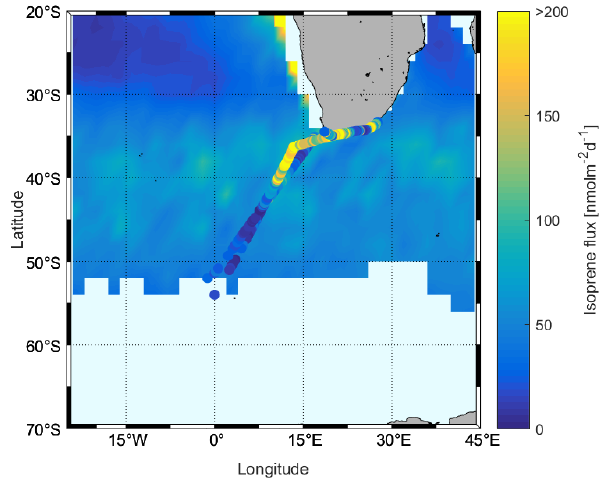
Figure 12. Comparison of calculated fluxes using W92 during the SCALE cruise (cruise track trace) and model-based fluxes using W92 from Booge et al. (2016) (background – monthly mean val- ues of August